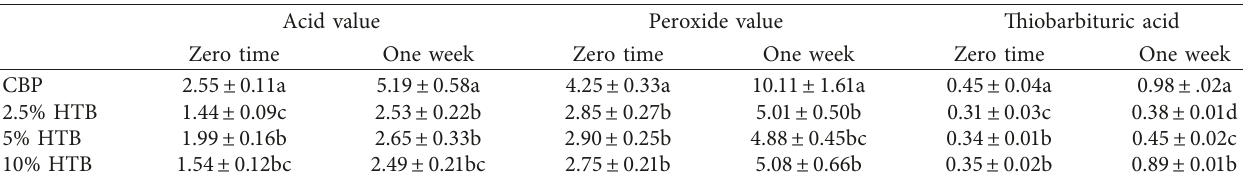
Values followed by different letters in each column differ significantly. Table 4: Effect of different concentrations of HTon the acid value, peroxide value, and thiobarbituric acid in beef at zero time and after one week of storage (mean values ± SD).